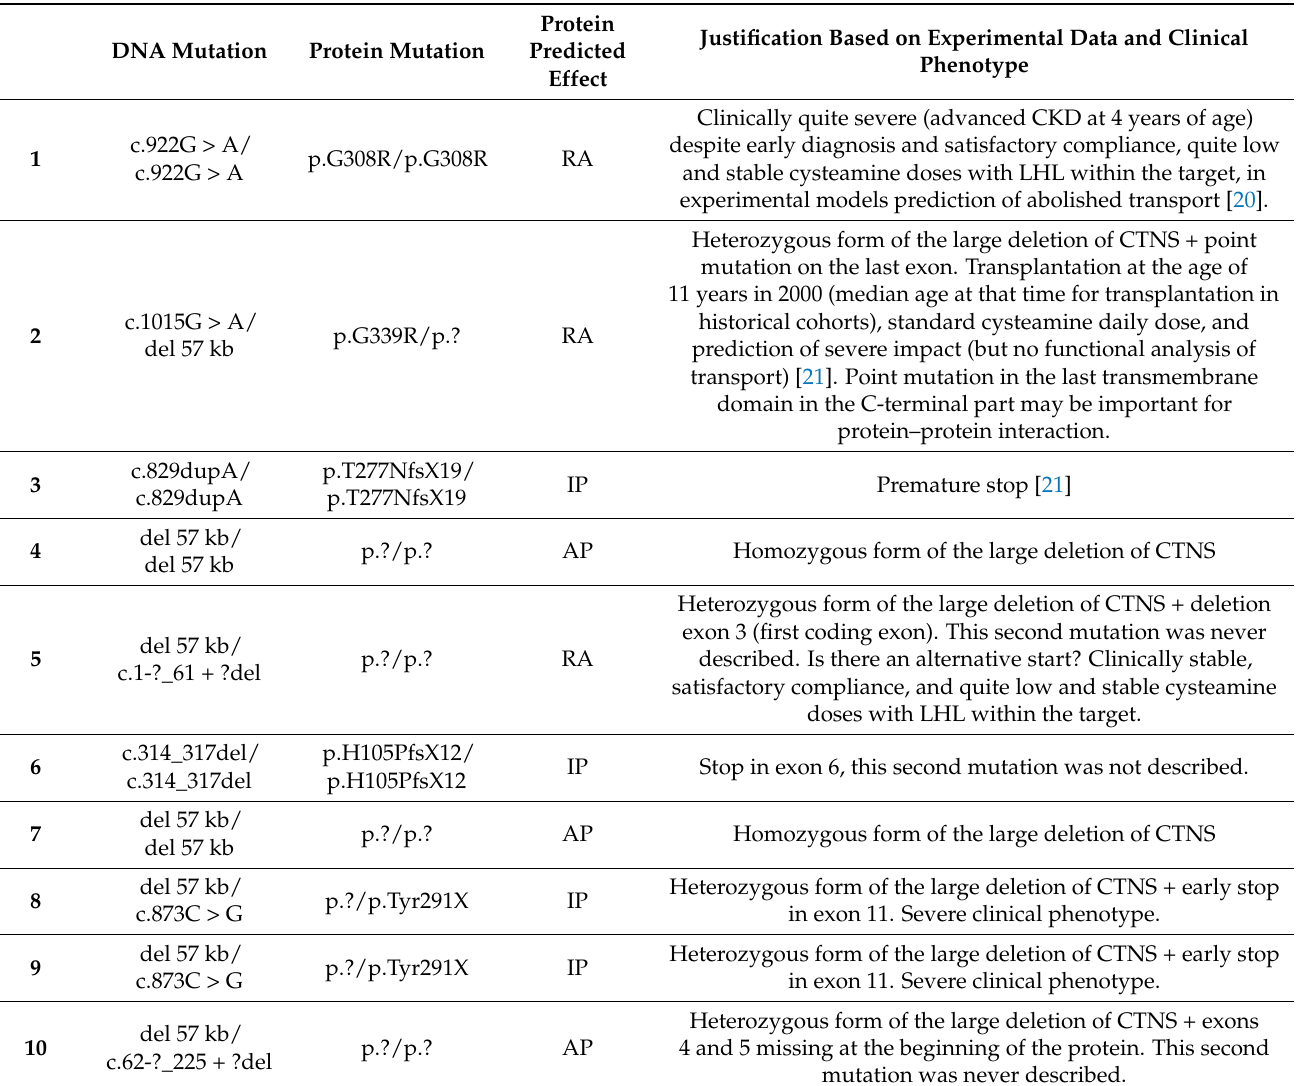
Table 5. Justification of the classification of the